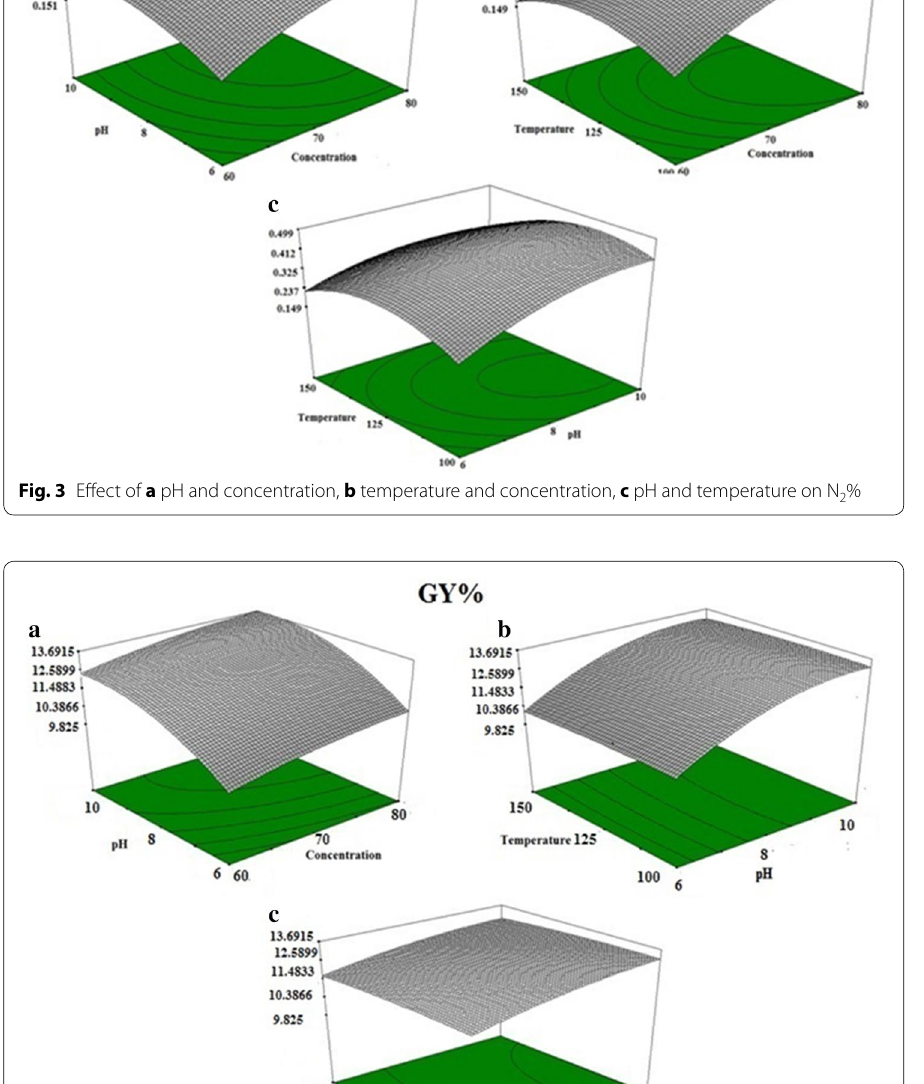
Change in tensile strength (TS)% With the increase in MCT β-CD concentration from 60 to 80 gpl at pH 6 and 125 °C, the change was from 2.34 to 3.56% up to 1.48%. At pH ~10 and 125 °C, TS% was − − + 6.03 to 5.85% up to 0.32%. This indicated that with the increase in the concentra- − − − tion of MCT β-CD, less loss is exhibited in TS%. But with the interaction of pH with